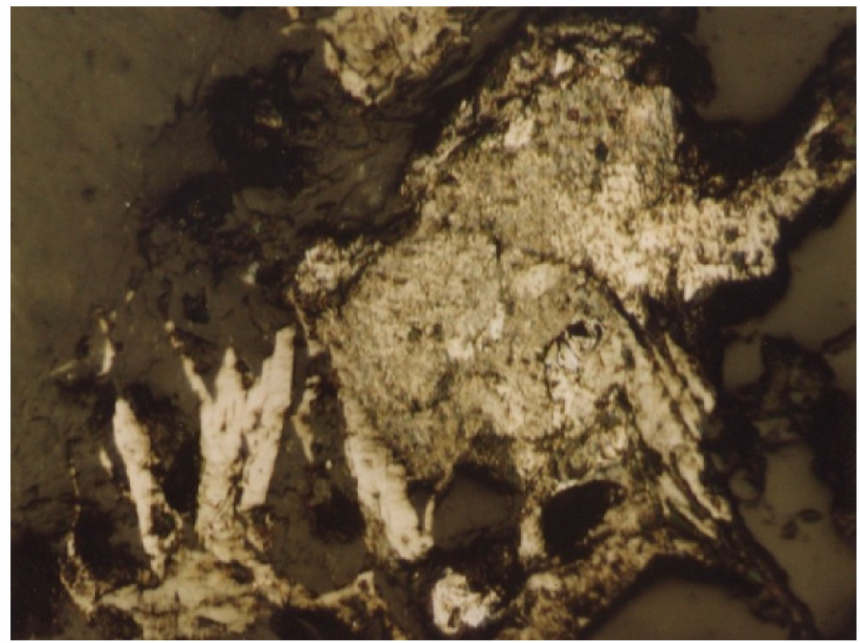
Figure 2. Lamellar aggregates of molybdenite (light gray) interspersed in quartz (black gray). Reflec- tion is 260 × .